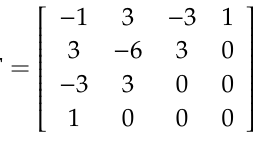
fruit was assumed to be symmetric, with respect to the symmetry planes (two planes) that define the final shape.